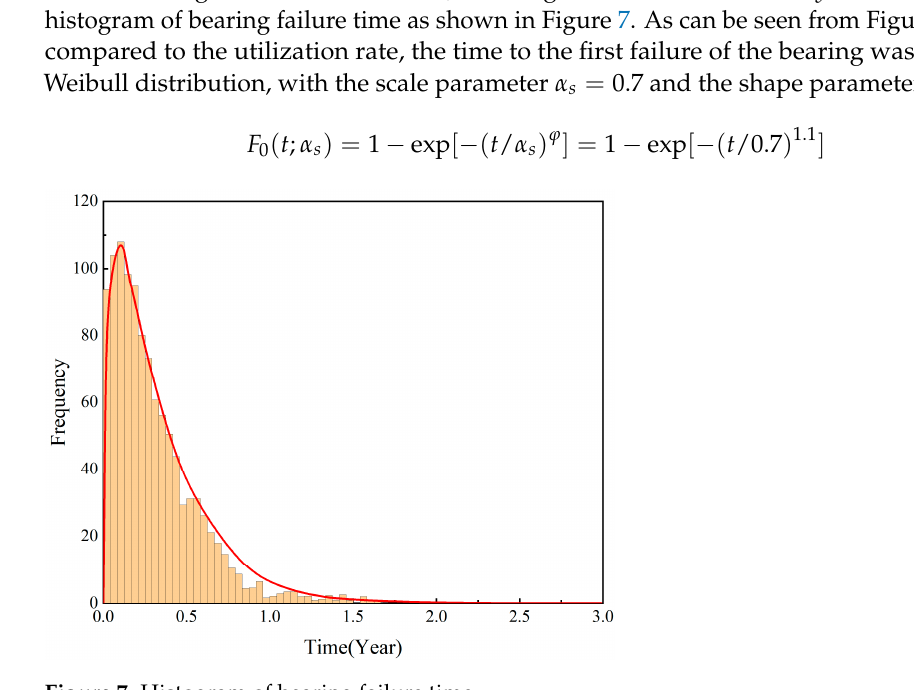
Figure 7. Histogram of bearing failure time For the rate of utilization r , the cumulative distribution function for bearing failure is: